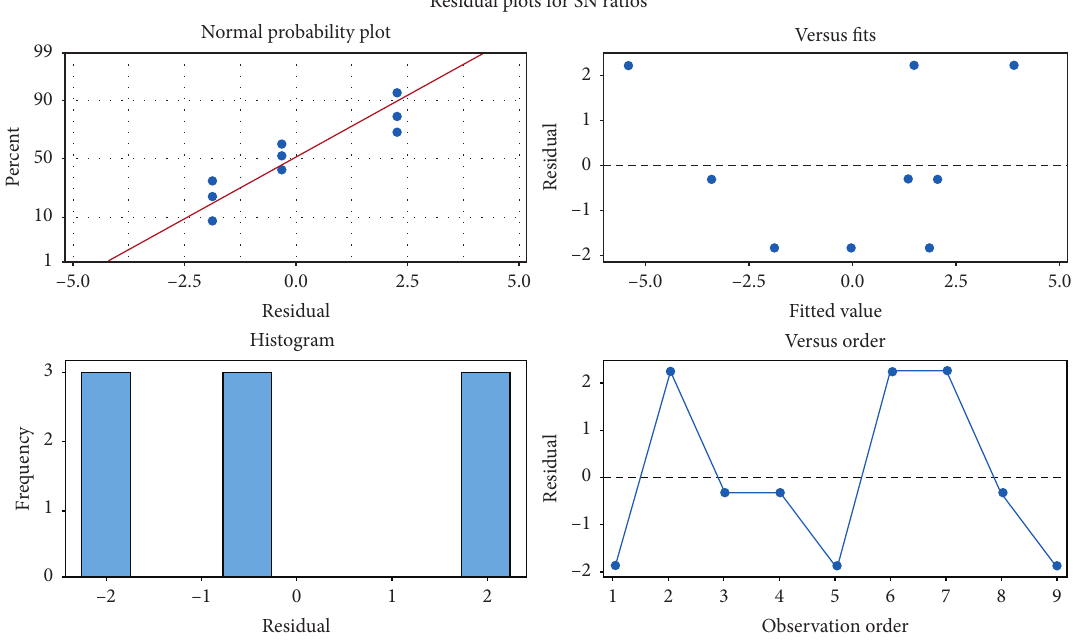
Figure 4: Tool wear’s residual plot of percent, frequency, fitted values, and observation Table 5: Surface roughness on the machined surface response ratios of signal to noise.